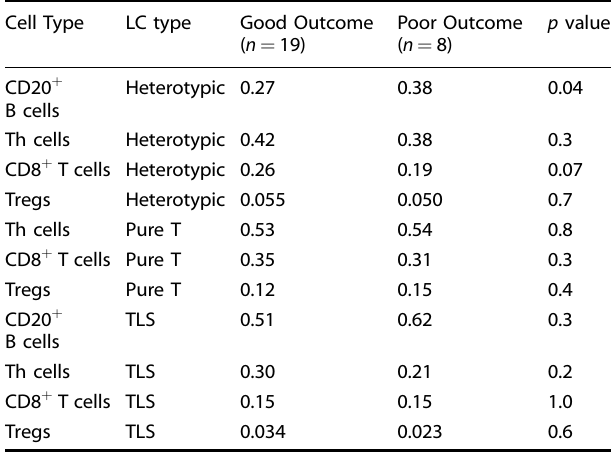
Table 2. Relative average proportions of B and T cells in heterotypic LCs, pure T LCs, and TLS.